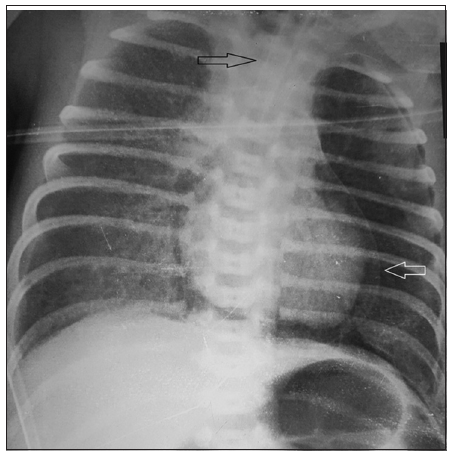
Figure 1: X-ray howing pneumomediastinum (white arrow) and endotracheal tube (black arrow)